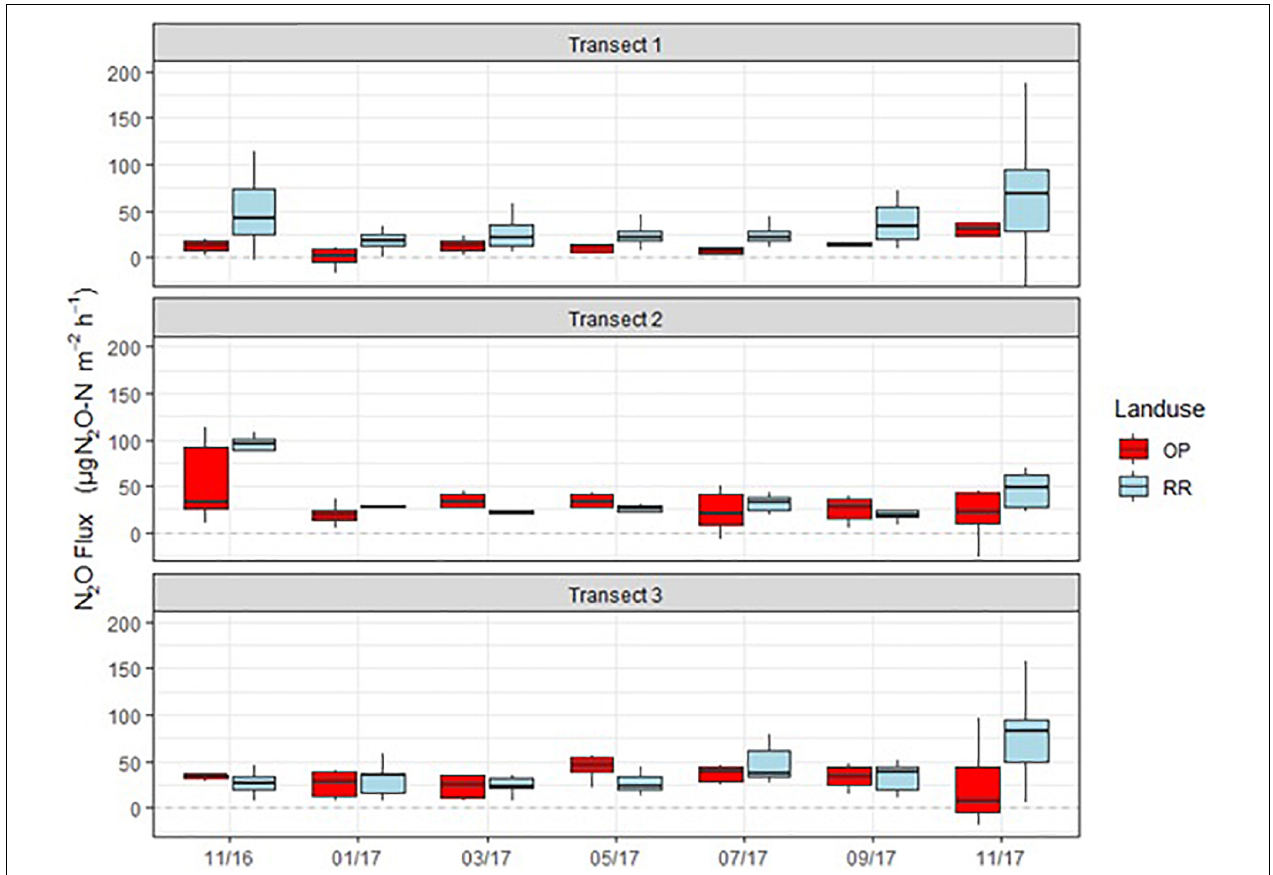
FIGURE 4 | Monthly N 2 O-N fluxes ( µ g m − 2 h − 1 ) from the three transects (1–3), OP, oil palm (red); RR, riparian forest (blue). The lower and upper hinges correspond to the first and third quartiles (the 25th and 75th percentiles), lower whisker = smallest observation greater than or equal to lower hinge –1.5 × IQR (inter quartile range), upper whisker = largest observation less than or equal to upper hinge +1.5 × IQR. The median is marked by a horizontal line inside the